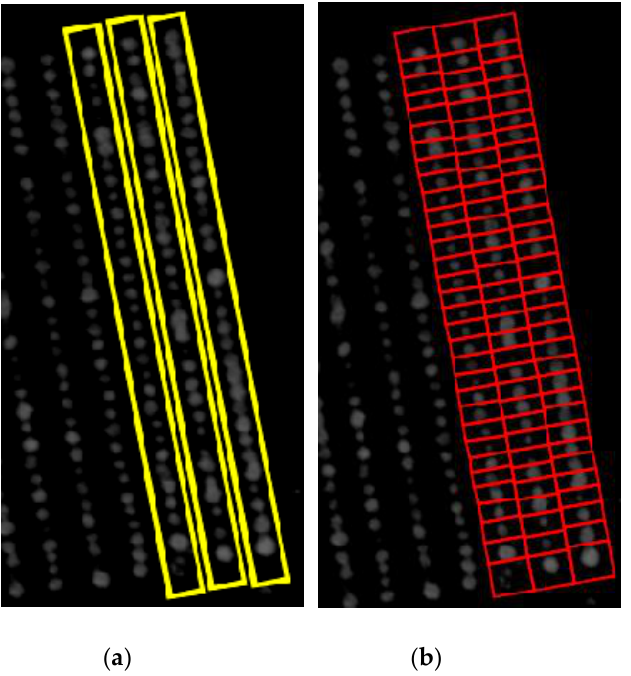
Figure 2. Bounding Boxes of ( a ) 3 plant-row boxes and ( b ) their individual plant boxes .